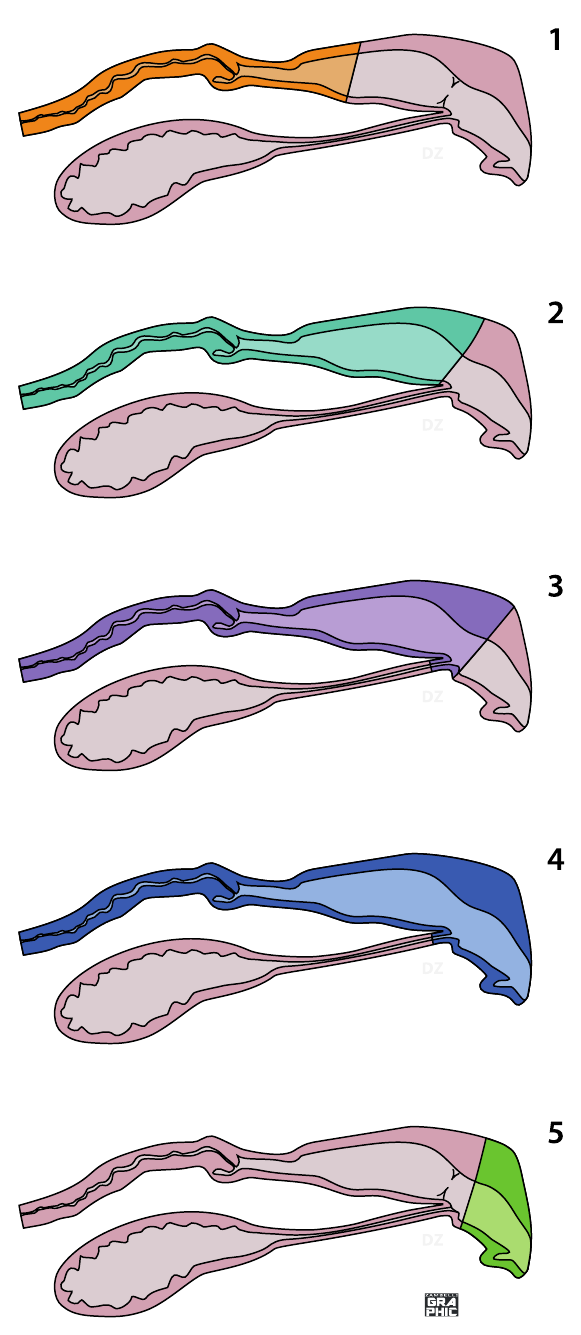
Figure 1. Schematic presentation of the five types of surgery: (1) partial vaginectomy (PV), consists in the ablation of the cervix and a variable length of the first part of the vagina; (2) complete vaginectomy (CV), all vaginal tissue, from the cervix to the hymen, are removed; (3) partial vestibule-vaginectomy (PVV), is similar to the complete vaginectomy, but a variable part of the vestibule is involved; (4) vulvo-vestibule-vaginectomy (VVV), consists in the ablation of the last part of the reproduction tract of the bitch, from the vulva to the cervix; (5) vulvo-vestibulectomy (VV), the externa genitalia and a variable vestibular length is removed.